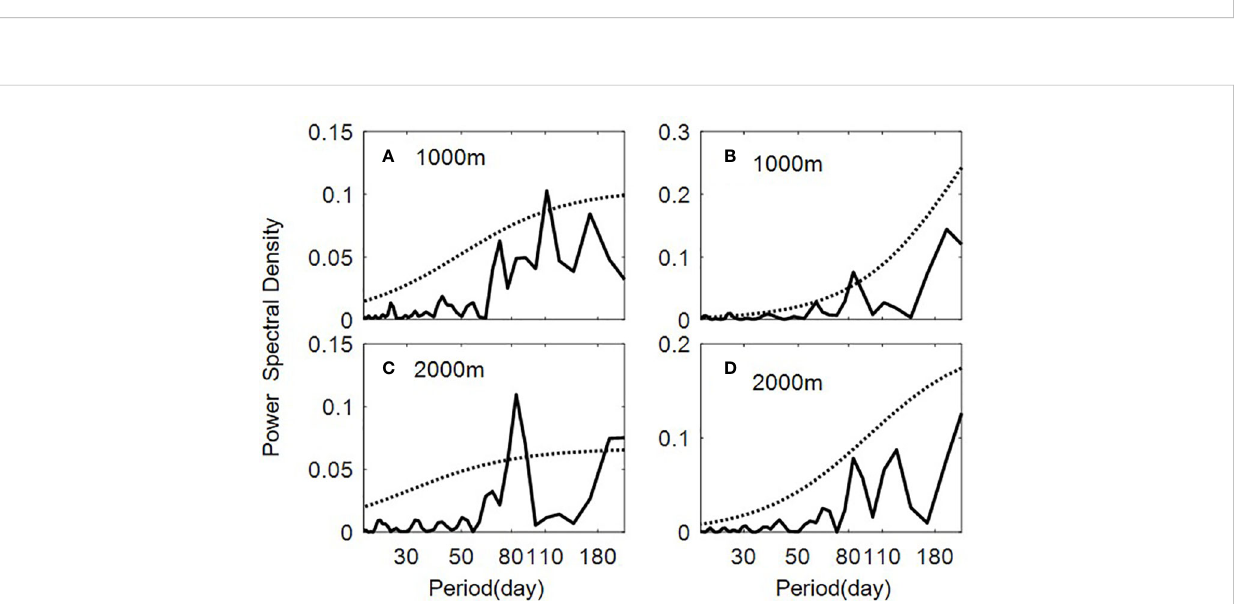
FIGURE 7 Power Spectral Density of zonal (left) and meridional (right) velocity recorded by Aqds-6000 current meters at (A, B) 1000 m, and (C, D) 2000 m. Dashed lines means the signi fi cance test of 95% con fi dence level.